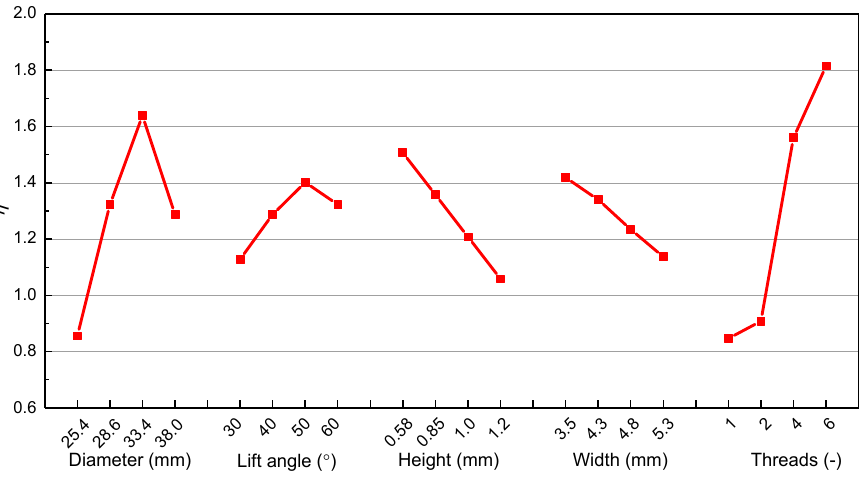
) defined by the ratio between pressure drop (cid:3005)(cid:3017) (cid:3281) /(cid:3005)(cid:3017) (cid:3294)